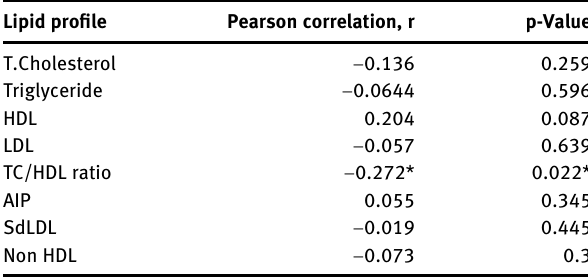
Table  : Demographic and clinical characteristics of study